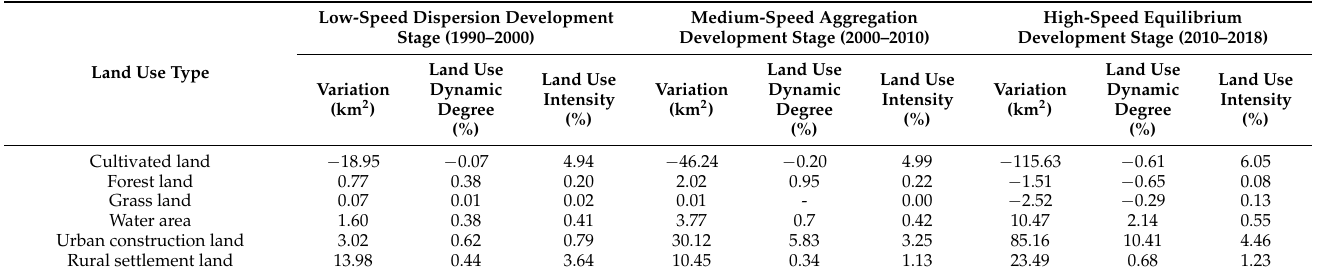
Figure 4. The total coal production and land use type in Huaibei City. Table 1. Land use change rate and land use intensity at different